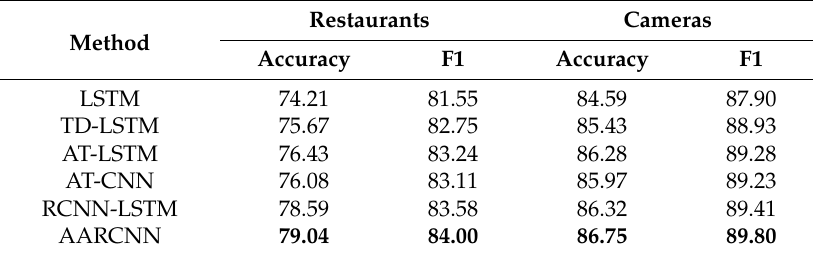
Table 2. Experimental data on Restaurants and Cameras dataset. Evaluation metrics are accuracy and F1 measure. Best scores are in